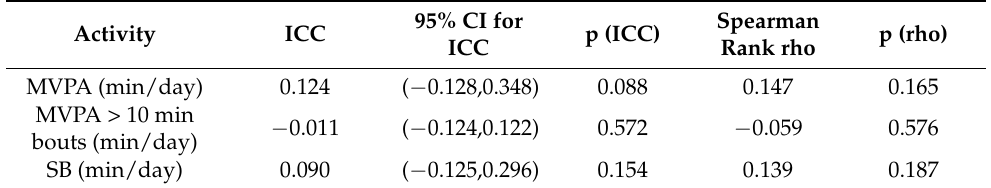
Table 3. Absolute agreement and correlation between objectively and subjectively measured MVPA and